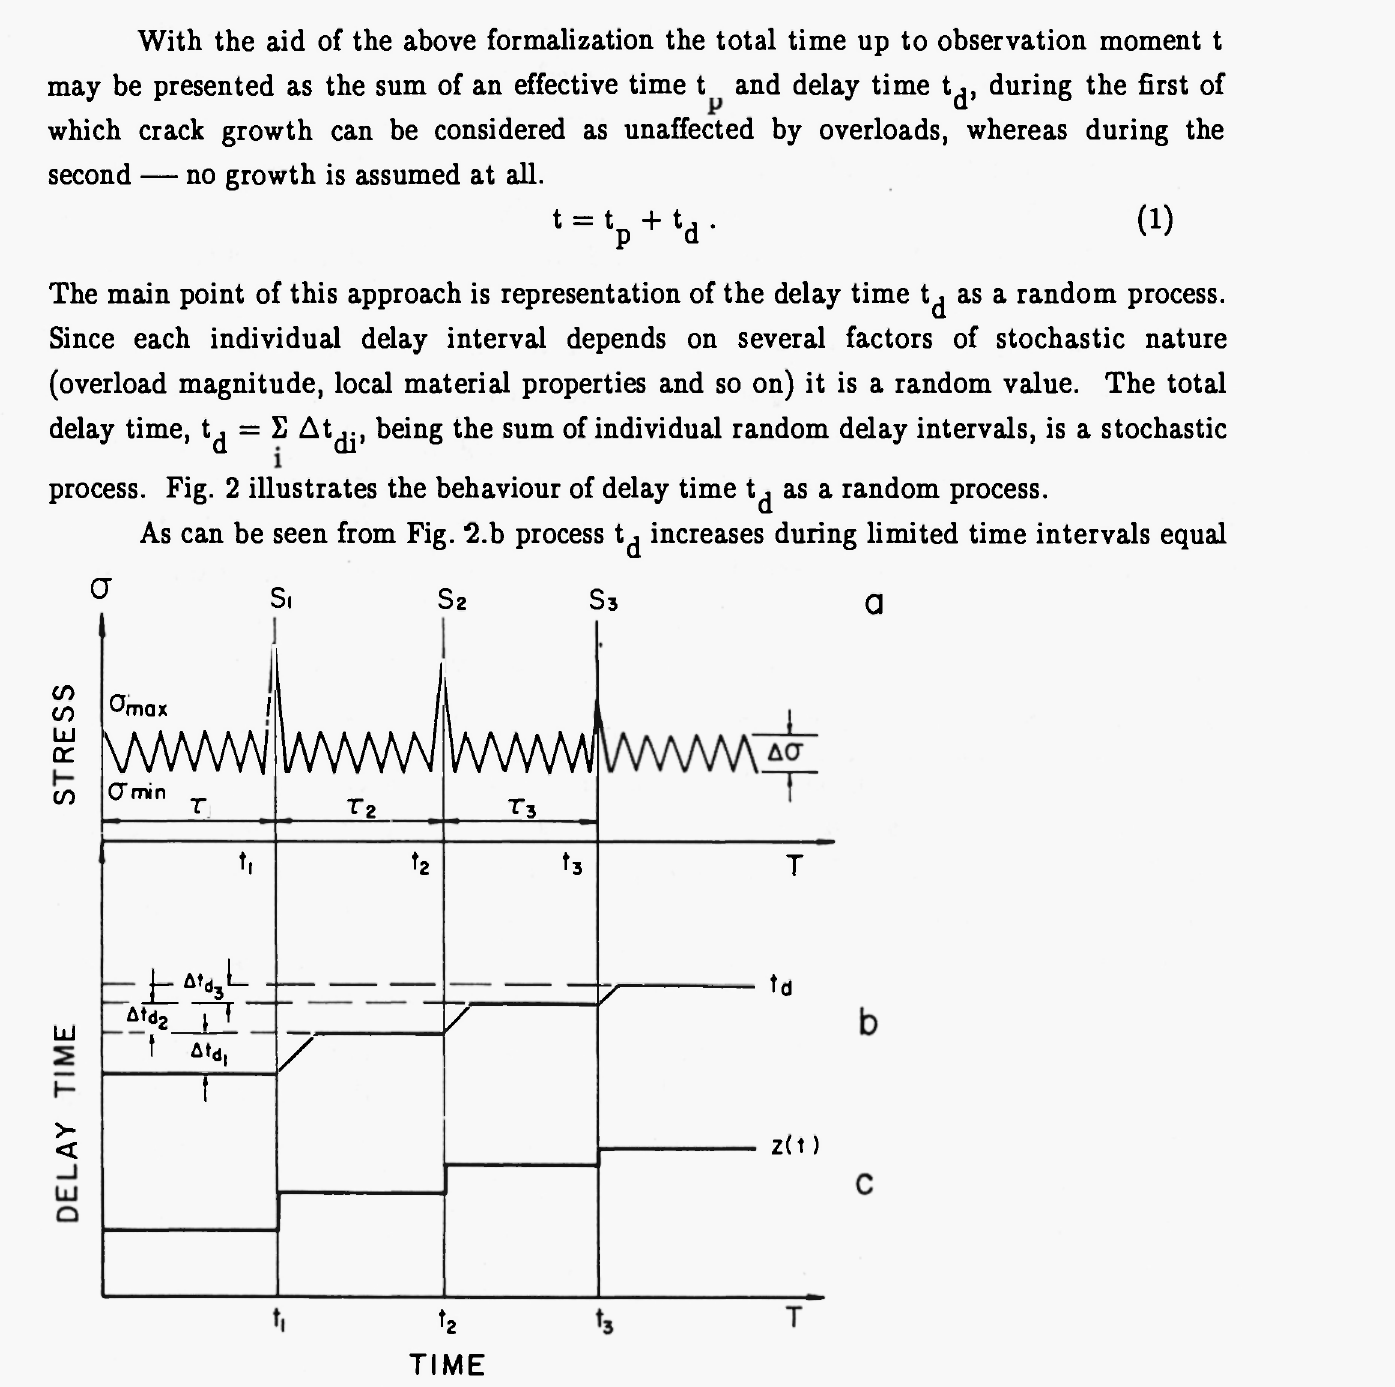
Fig. 2 Schematic representation of delay time as a random process (a) Base—line constant amplitude load with superimposed overloads as in Fig. la. (b) Delay time t^. (c) Representation of delay time by step—function